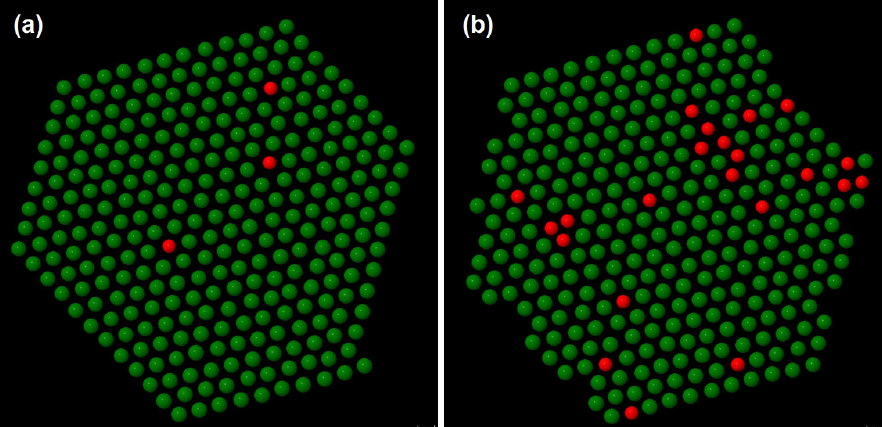
Figure 2. Snapshots of (111) planes of Ar-Xe mixtures at T = 84 K and ( a ) x Ar = 0.02 and ( b ) x Ar =